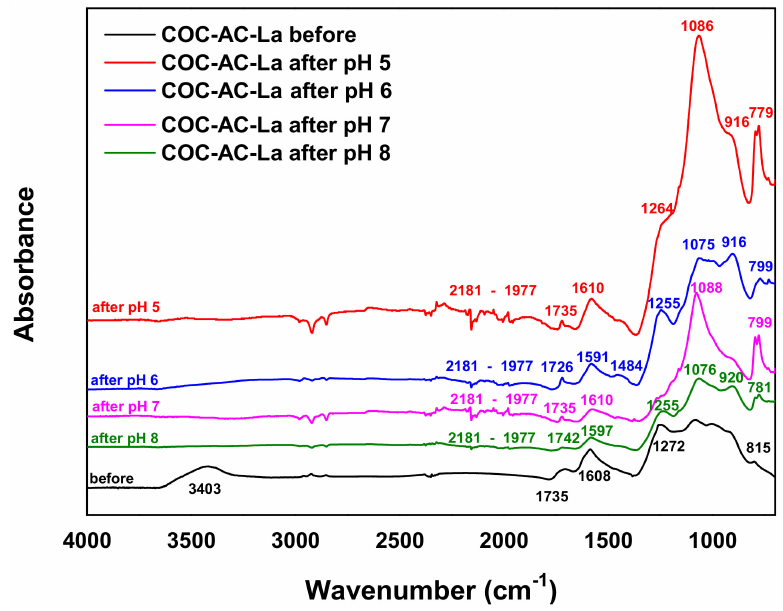
Figure 2. FTIR spectra of COC-AC-La before and after Cr(VI) adsorption at pH values 5, 6, 7 and